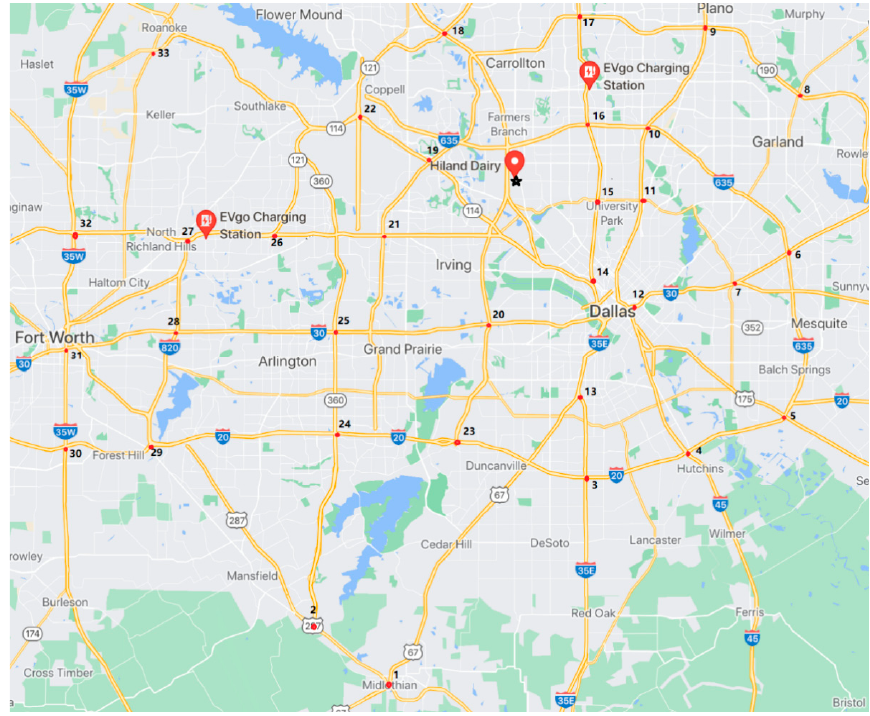
Table 7. Routing parameters in NR-EGA.